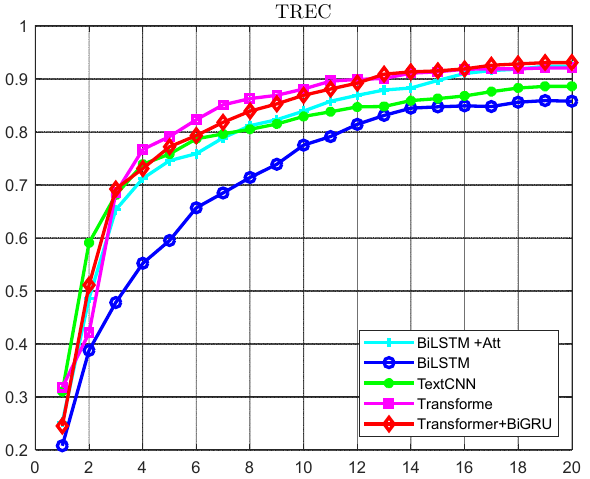
Figure 7. Comparison of accuracy rates on the TREC verification set.